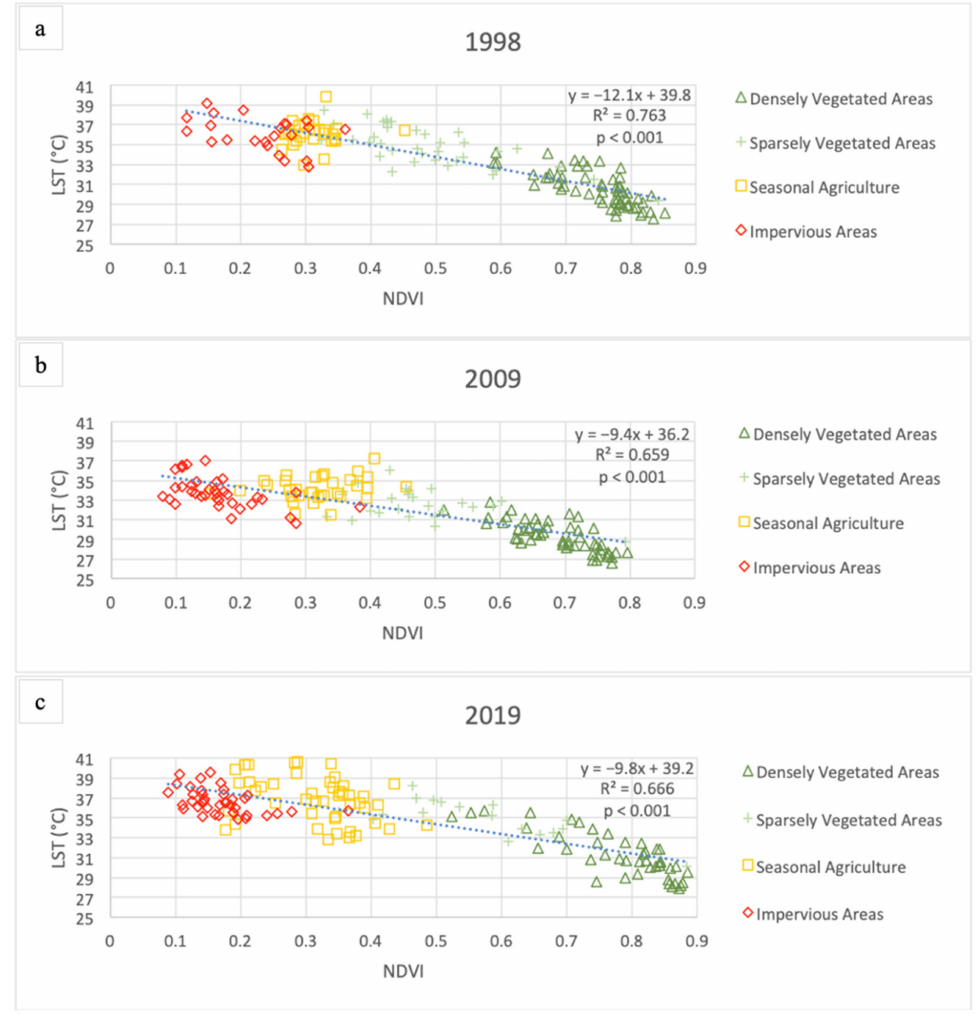
Figure 5. LST-NDVI linear regressions. ( a ) 1998 linear regression, ( b ) 2009 linear regression, and ( c ) 2019 linear